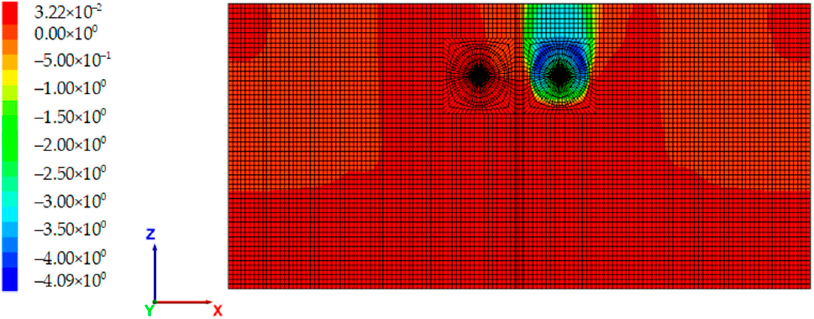
Figure 10. The z-direction displacement contour of the unreinforced tunnel end (unit: m).